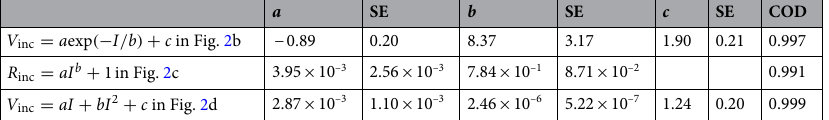
Table 1. Fitting parameters. SE standard error, COD coefficient of